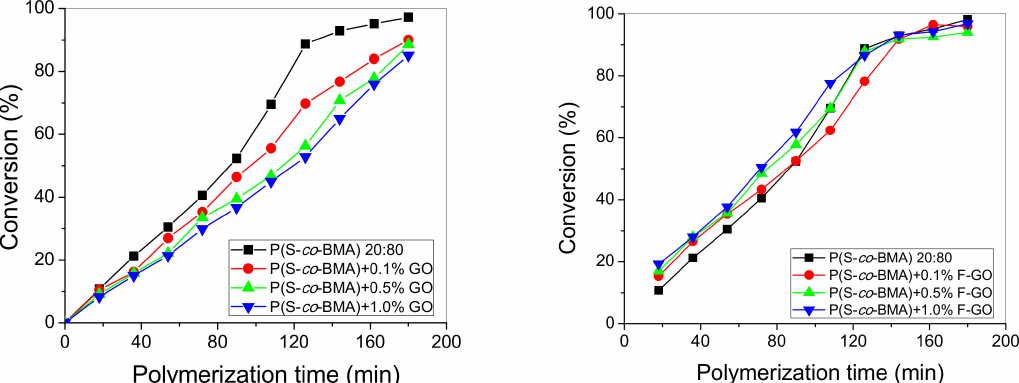
Figure 3. Variation of monomer conversion with polymerization time during bulk in-situ radical polymerization of styrene with n-butyl methacrylate, 20:80 at 80 ◦ C at various graphene oxide ( a ) or functionalized graphene oxide ( b )